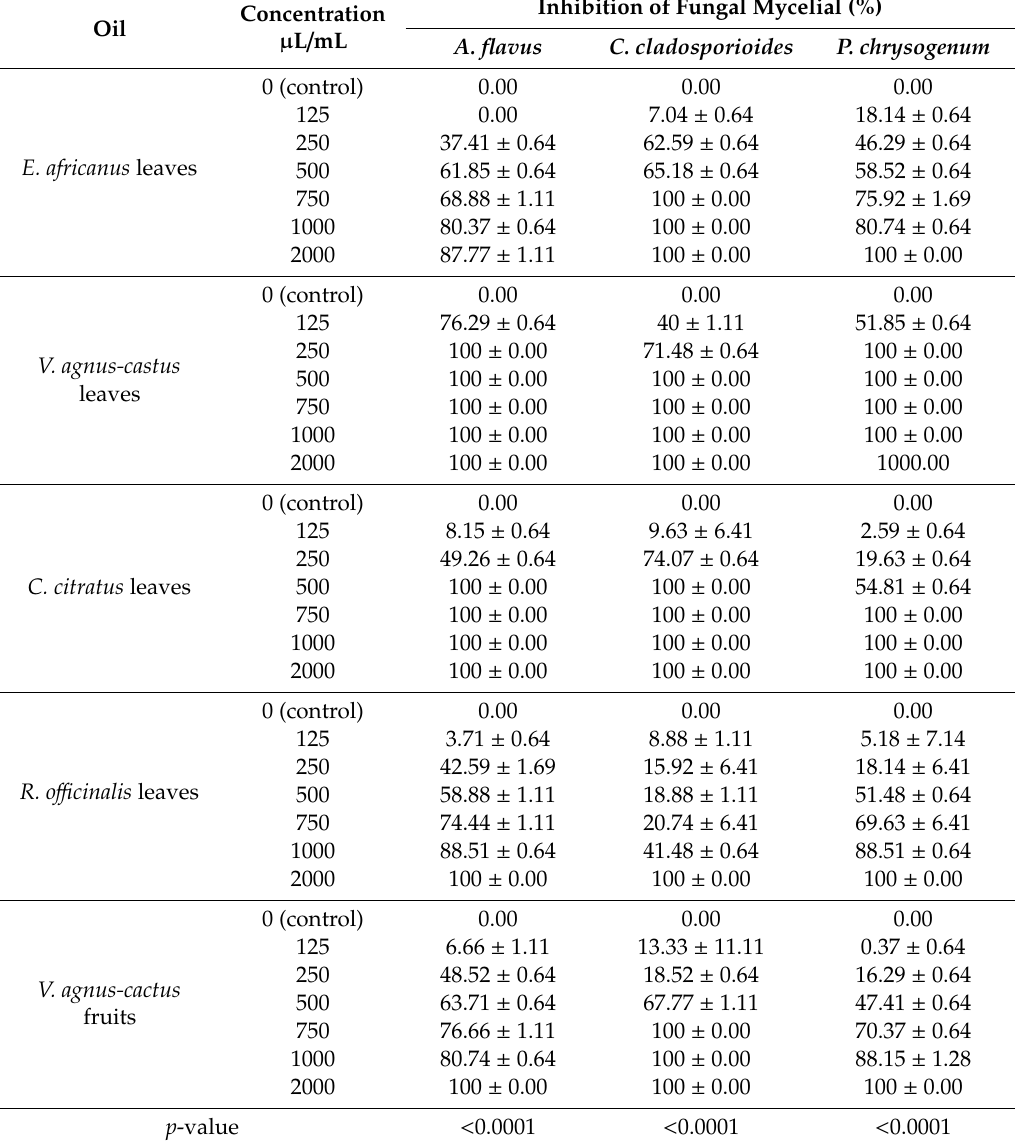
Table 1. The e ff ects of essential oil (EO) concentrations on the inhibition of the fungal mycelia (%) of A. flavus , Cladosporium cladosporioides , and P.